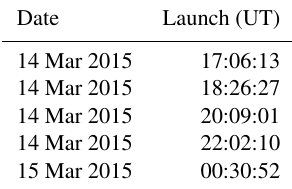
Table 2. List of radiosonde